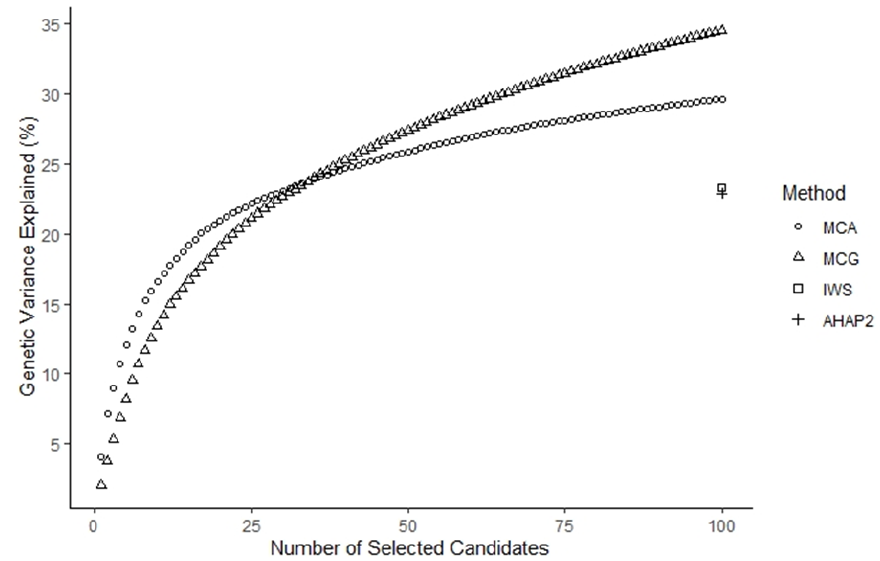
Figure 3. Diagonal values of A * representing the percentage of genetic variance explained for each additional selected candidate for whole-genome sequencing using the MCG method ( top ) or MCA method ( bottom ). The IWS and AHAP2 methods are presented as singular dots where 100 animals have been sampled.